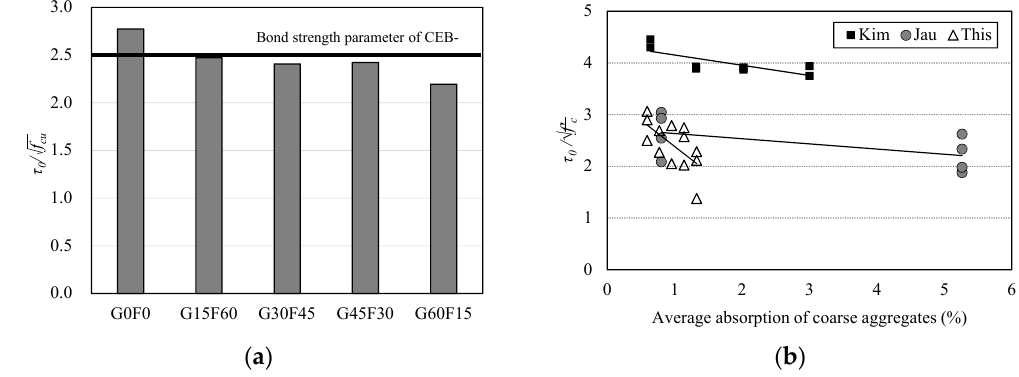
Figure 5. Normalized bond strength of pull-out specimens. ( a ) Relation with replacement level; ( b ) Relation with average absorption of coarse aggregate.